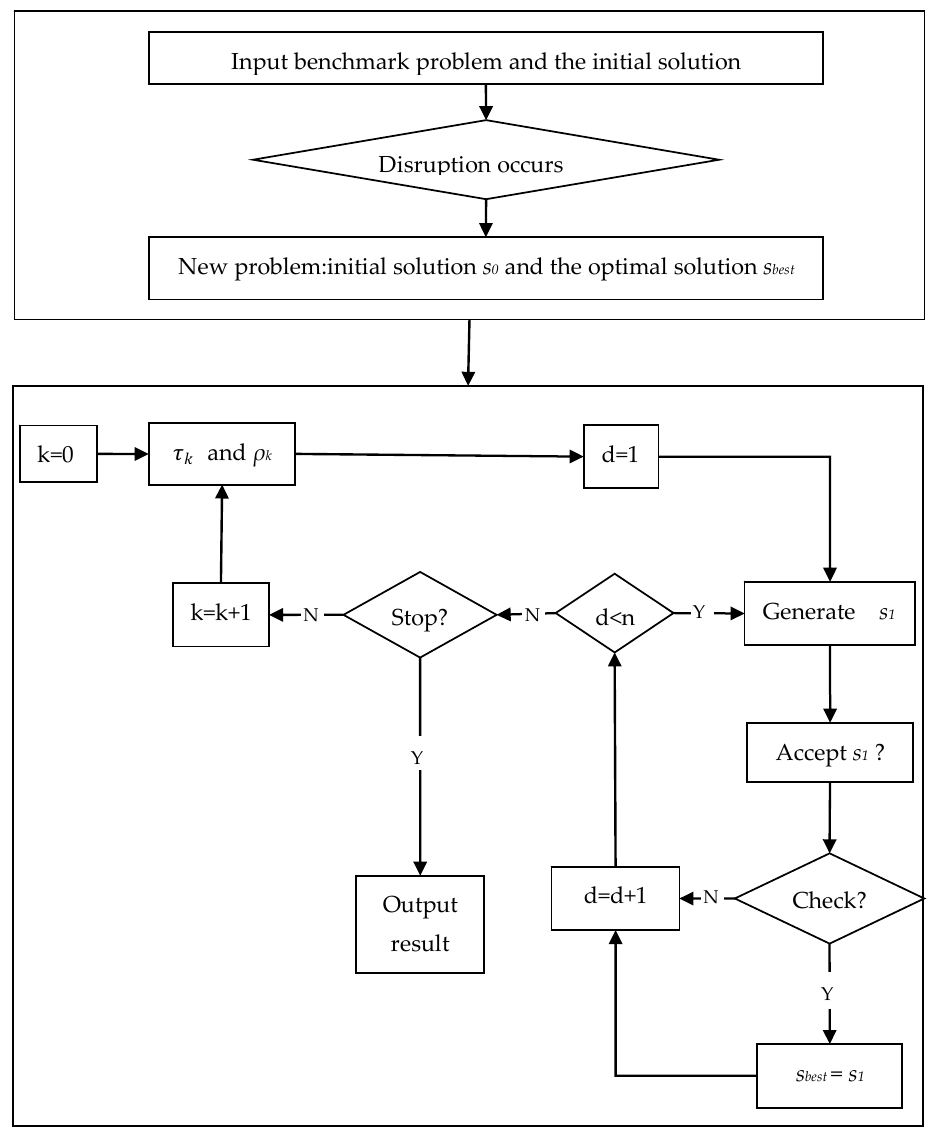
Figure 2. Outline of ICAHP algorithm.